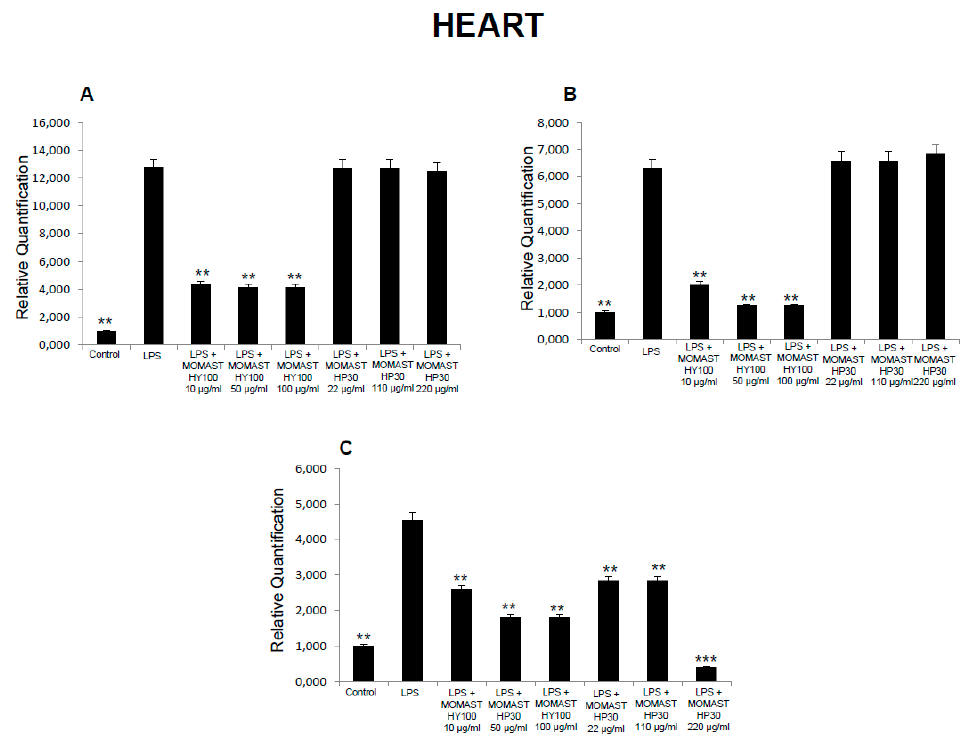
Figure 8. Effects of MOMAST( ® ) HY100 (10, 50, and 100 µg/mL) and MOMAST( ® ) HP30 (22, 110, and 220 µg/mL) on ( A ) cyclooxygenase (COX)-2, ( B ) tumor necrosis factor α (TNF α ), ( C ) and inducible nitric oxide synthase (iNOS) in rat heart specimens. Data were reported as means ± SEM. ANOVA, p < 0.01; post-hoc test, ** p < 0.01, *** p < 0.001 vs. LPS-treated